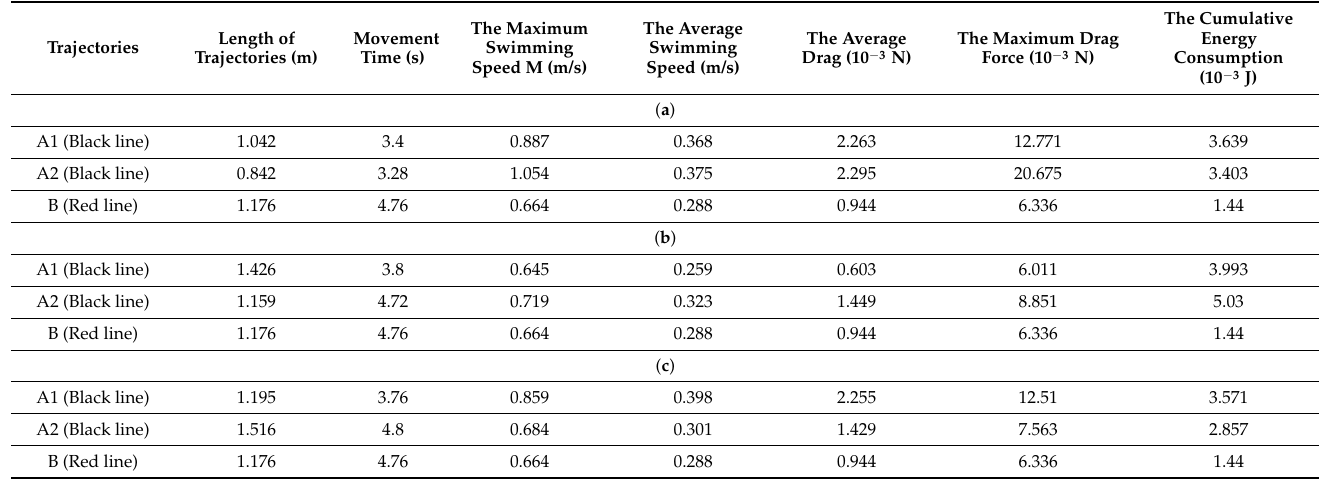
Table 3. ( a ) The fish movement parameters of typical 1. ( b ) The fish movement parameters of typical 2. ( c ) The fish movement parameters of typical